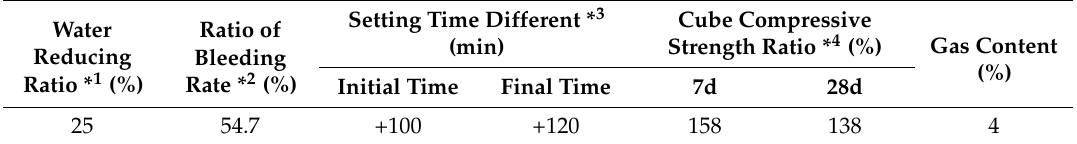
Table 8. Properties of polycarboxylate